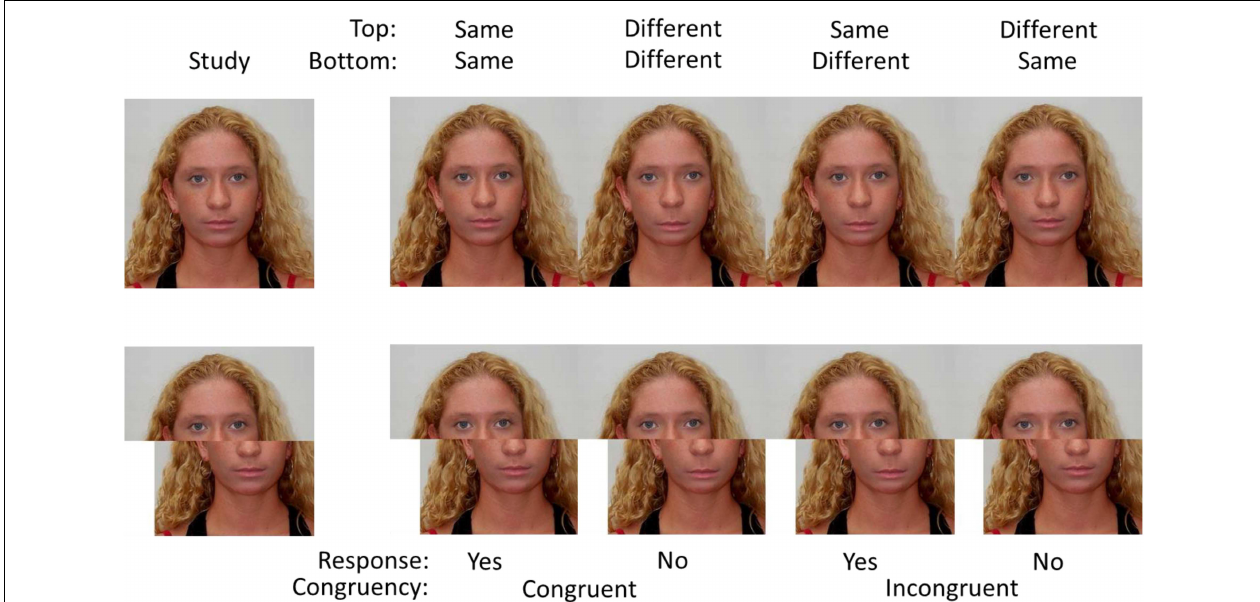
FIGURE 3 | Examples of trials in Experiment 1. The task was to determine if the eyes are the same when the eyes and/or the mouth may have been changed. The top images show the aligned faces whereas the bottom images show the misaligned images.